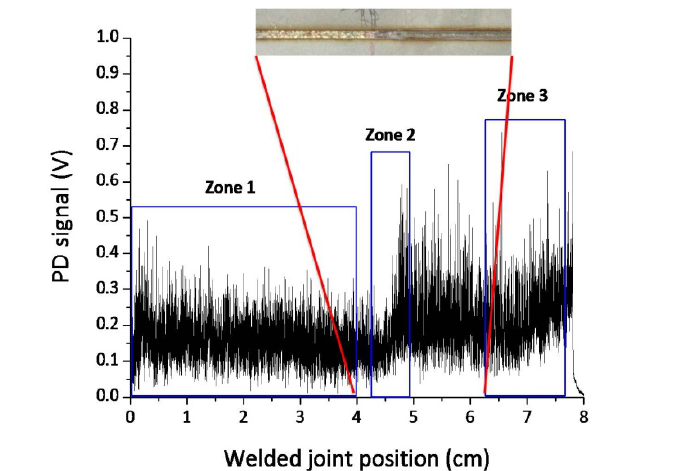
Figure 8. (a) Photodiode signal detected obtained for variable gas flow rate. Welding parameters: P = 1.8 kW, v = 80 mm/s, Q = from 100 L/min (Zone1) to 0 L/min (Zone